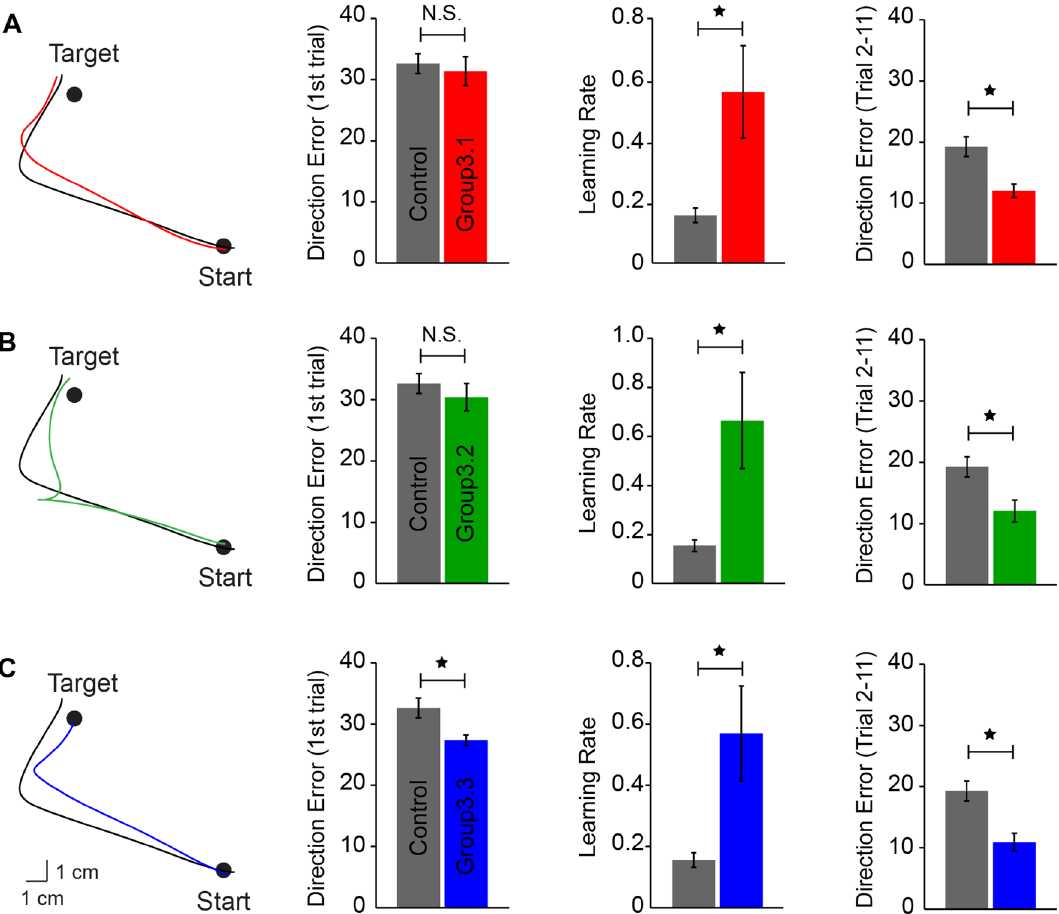
Figure 6. Hand-paths from representative subjects observed on the first trials during the transfer session were compared between the experimental groups (color) and the control (black) in the left panels for 3.1, 3.2, and 3.3, respectively ( A–C , first column). Mean errors of the first trial were compared (mean ± standard error) in the second column panels ( A–C ,), the learning rates were plotted on the third column panels ( A–C ), and the mean errors from trial 2–11 were plotted on the fourth column panels ( A – C ). N.S. indicates not significant. * p <